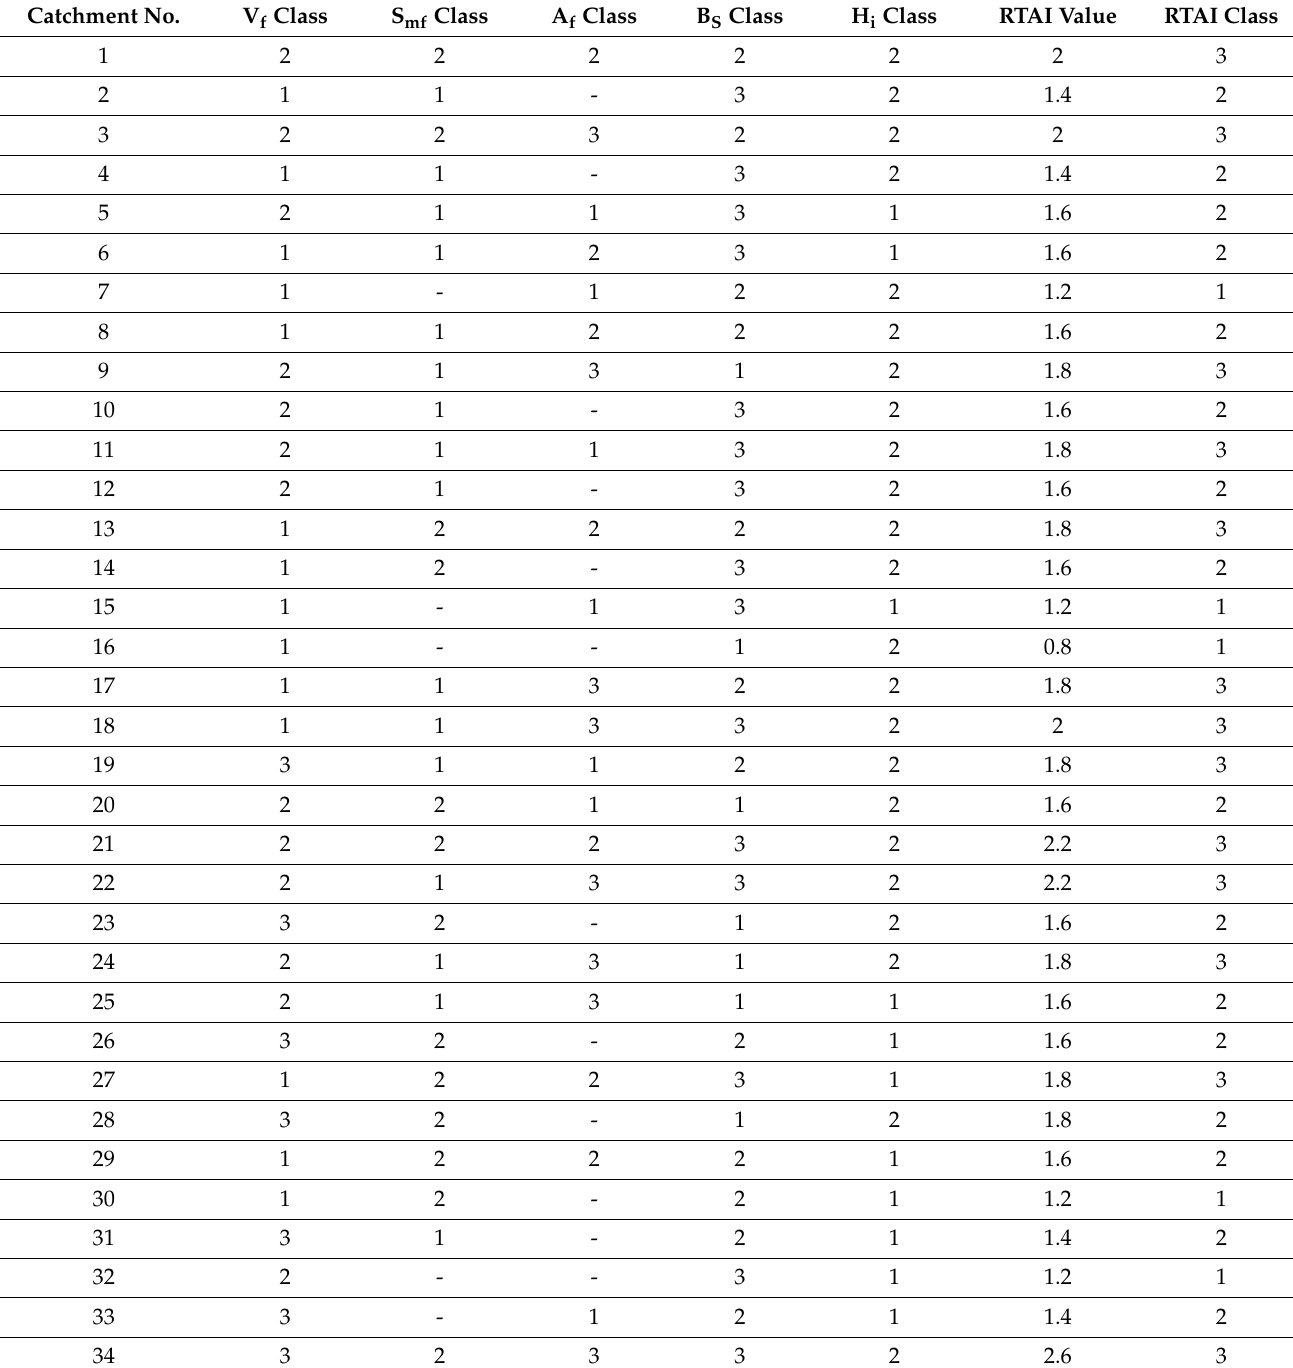
Table 2. Values and classes of morphological indexes and relative tectonic activity index (RTAI). Catchment